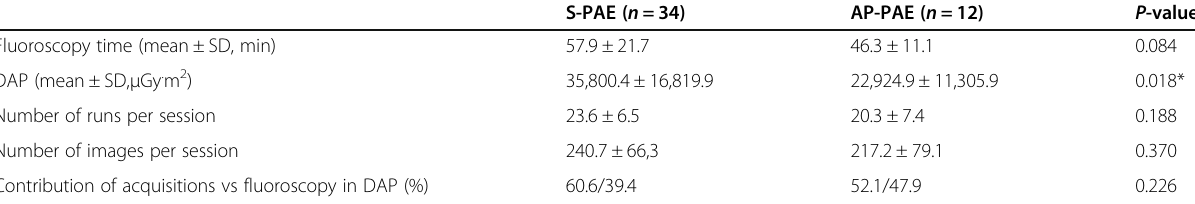
Table 2 Comparison of radiation dose - related features of PAE for the two groups